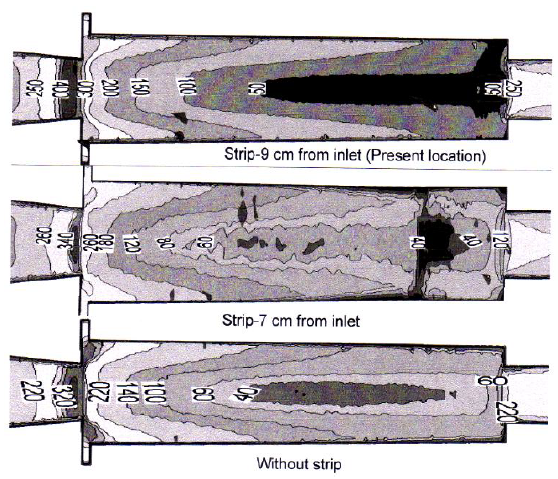
Figure 23. Contours of total velocity magnitude (m/s) along axial cross section of vortex tube for different location of strip.